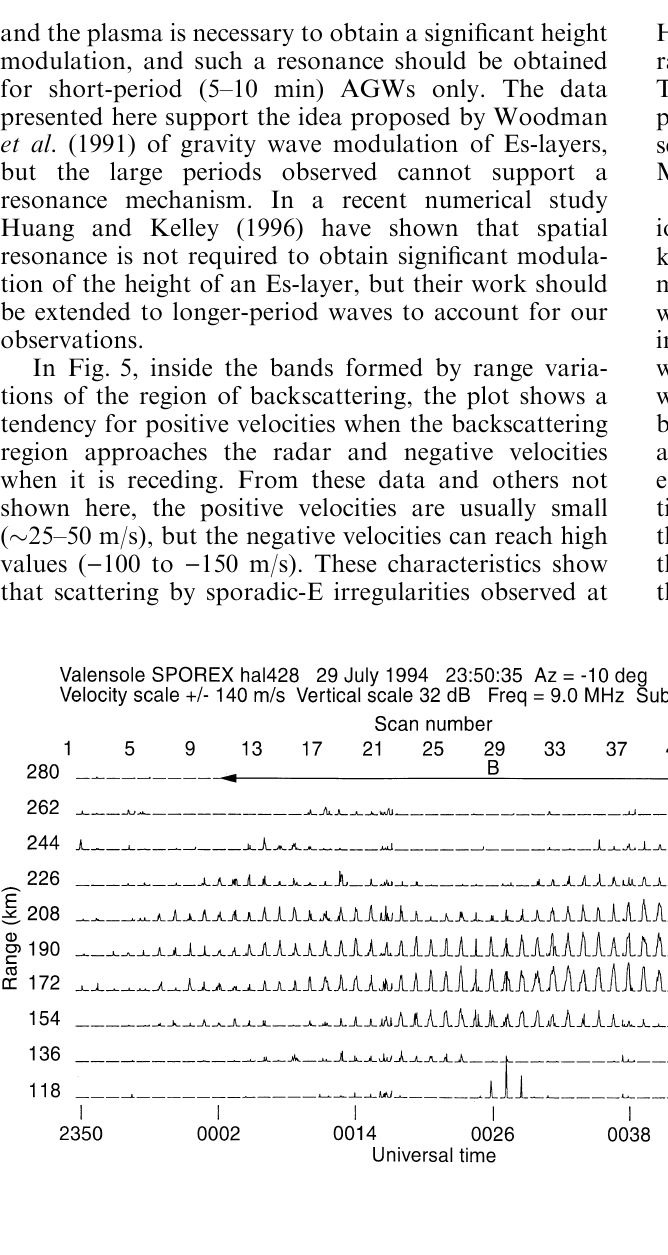
Fig. 9. Time evolution of E-region magnetic aspect sensitive echoes at 9 MHz in azimuth 10 (cid:176) W in the time-period 2245–2348 UT. The Doppler spectrum at any cell is logarithmic on a 28-dB scale with the Doppler velocity ranging from ) 140 to 140 m/s. A region of backscattering, forming a band with a positive range rate of about 70–90 m/s, is observed from 2317 UT to the end of the record at 2348 UT